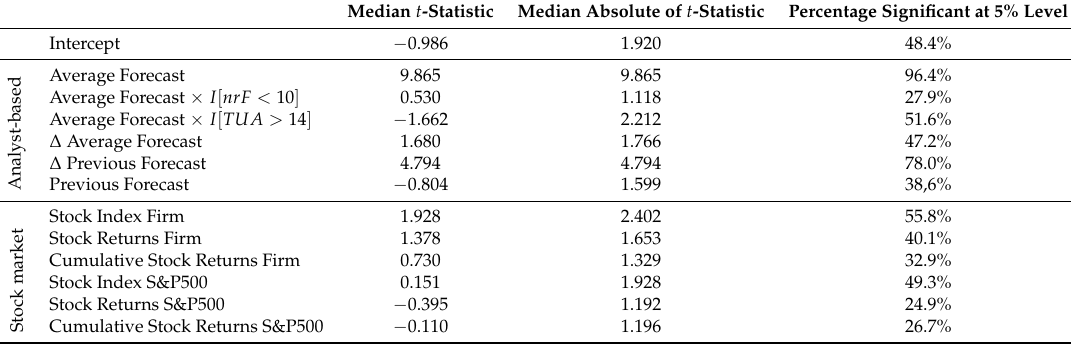
Table 4. A summary of t -Statistics when forecasting earnings forecasts. Results are for the estimation sample, which amounts to 316 firms, 18,338 forecasters and 146,319 forecasts (on average slightly more than 463 forecasts per firm). As variable to be explained, we used the earnings forecasts by the analysts. As explanatory variables, we included the variables mentioned in Table 2. The regression was run individually for each firm, and the table shows statistics which summarize these